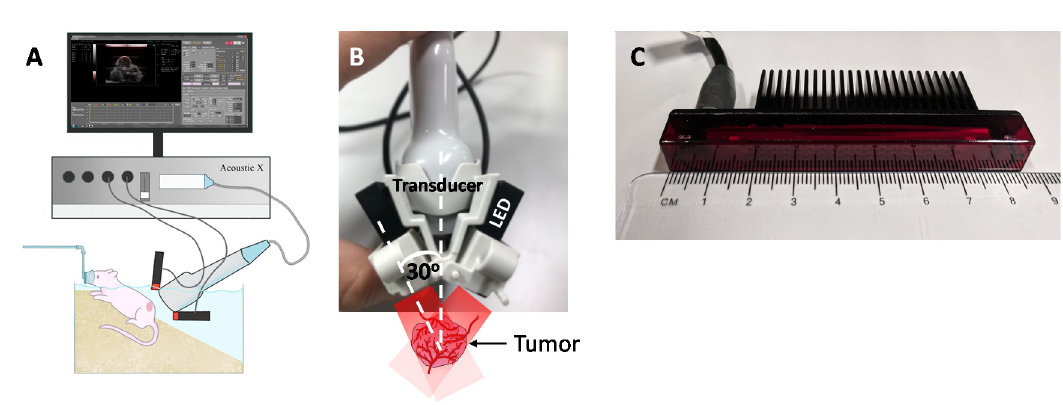
Figure 1. ( A ) Schematic of our experimental setup in which the Light-Emitting Diode (LED)-based photoacoustic (PA) system was utilized for imaging subcutaneous tumors in a mouse. ( B , C ) LED array used for illumination and the angle at which the LEDs are connected to the ultrasound transducer. (Scale bar = 2